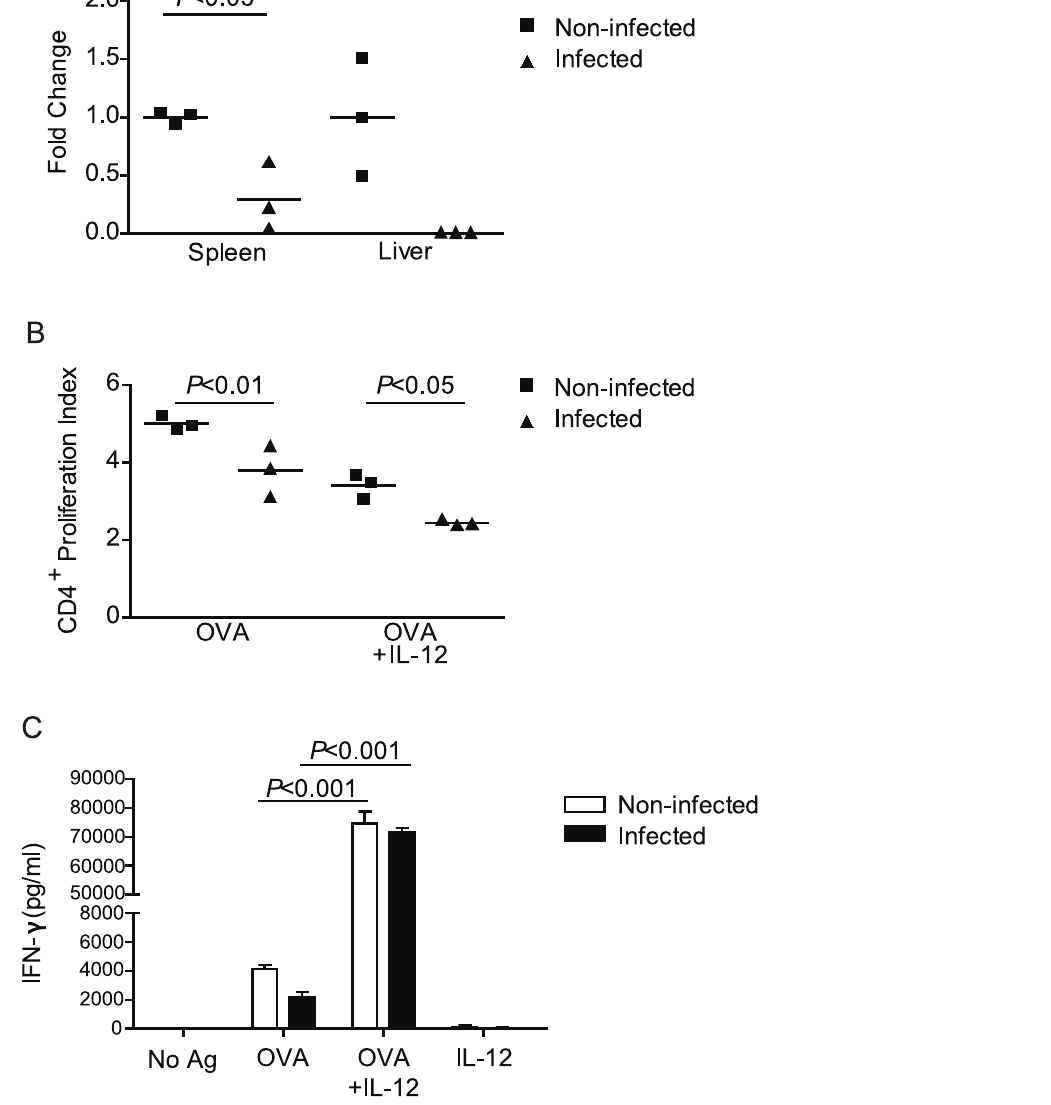
Figure 8. Suppression of IL-12 expression may contribute to impairment of T cell responses during pre-patent schistosome infection. A, Taqman real-time PCR gene expression assay for IL-12p35 was performed on RNA isolated from tissue of the spleen or liver of 4 week S. mansoni -infected or non-infected mice wild type mice. Fold change was calculated using the comparative C T method and GAPDH as the endogenous control. B and C, Splenocytes isolated from 4 week S. mansoni infected or non-infected RAG-1 2 / 2 mice or and CFSE-stained CD4 + T cells isolated from non-infected OT-II/RAG-1 2 / 2 mice were co-cultured for 72 hours without antigen, with indicated combinations of OVA peptide and IL-12, or with anti-CD3 antibody. CD4 + T cell proliferation was analyzed by flow cytometry (B) and the concentration of IFN- c in the cell culture supernatants was measured by ELISA (C). Horizontal bars represent mean of 3 independent mice (A, B). Data shown are mean + / 2 SEM (C). No Ag, no antigen; OVA, OVA peptide; a CD3, anti-CD3